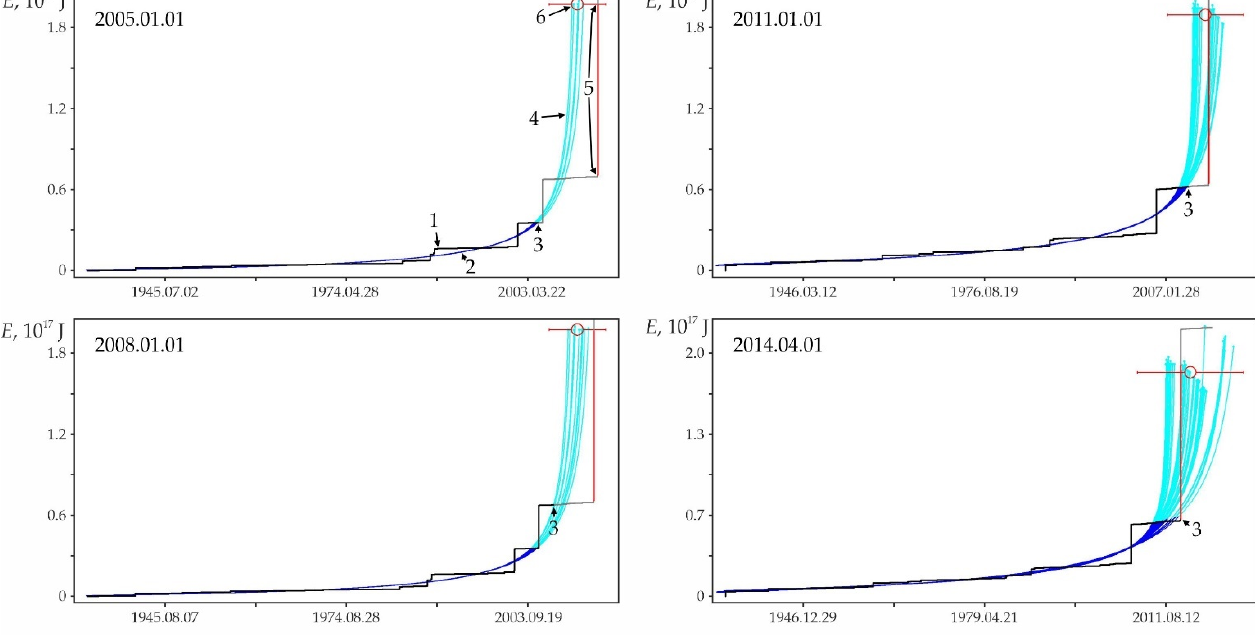
Figure A14. Retro predictability of the earthquake on 1 April 2014 in the zone with the highest (at the estimate date; see Figure A13, column ‘a’) number of successful predictive extrapolations (see Figure A4 for explanations). Table A10. Retro estimation of the place and time of the earthquake on 1 April 2014 by the cluster of its precedent activity.